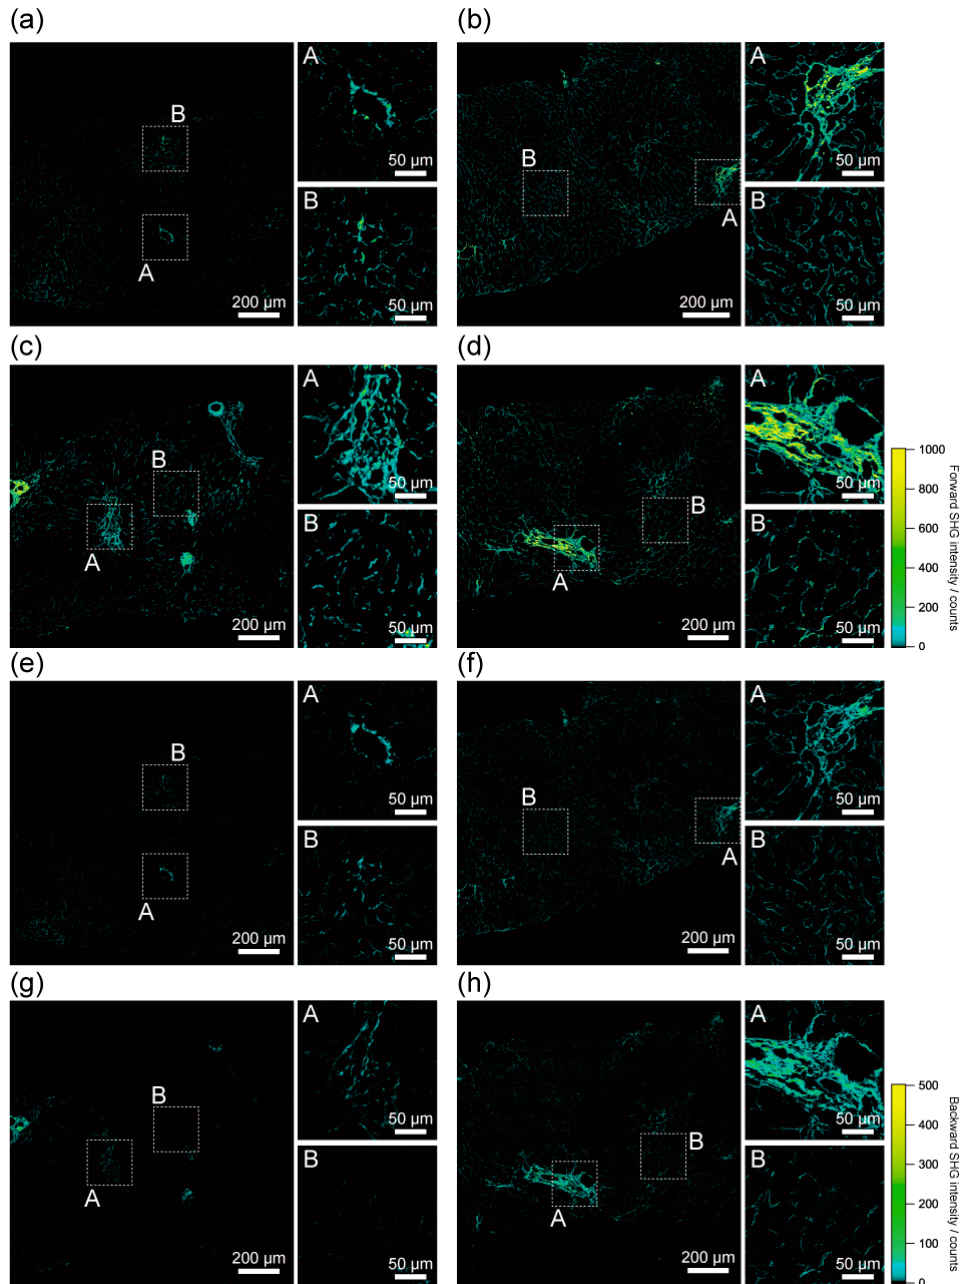
Figure 2. Histological assessment of the livers of NAFLD patients by SHG imaging. Forward-detected SHG images of ( a ) ultra-early stage of NAFLD (Patient 1), ( b ) ultra-early stage of NAFLD (Patient 2), ( c ) early stage of NASH (Patient 3), and ( d ) advanced stage of NASH (Patient 4). Backward-detected SHG images of ( e ) ultra-early stage of NAFLD (Patient 1), ( f ) ultra-early stage of NAFLD (Patient 2), ( g ) early stage of NASH (Patient 3), and ( h ) advanced stage of NASH (Patient 4). Enlarged images of the dashed square regions are also shown.